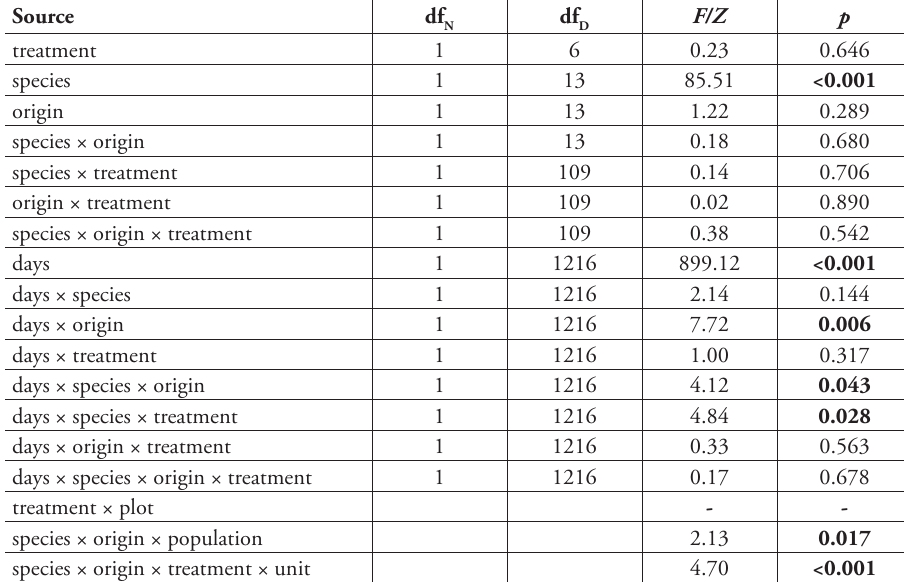
Table 4. Results of the repeated measures analysis of the within-species approach testing for local adapta- ( p ) are given. ‘Treatment × plot’. ‘species × origin × population’ and ‘species × origin × treatment × unit’ interactions were considered random effects and a Z-value instead of F-value is provided. Bold numbers indicate significant p-values ( p < 0.05).